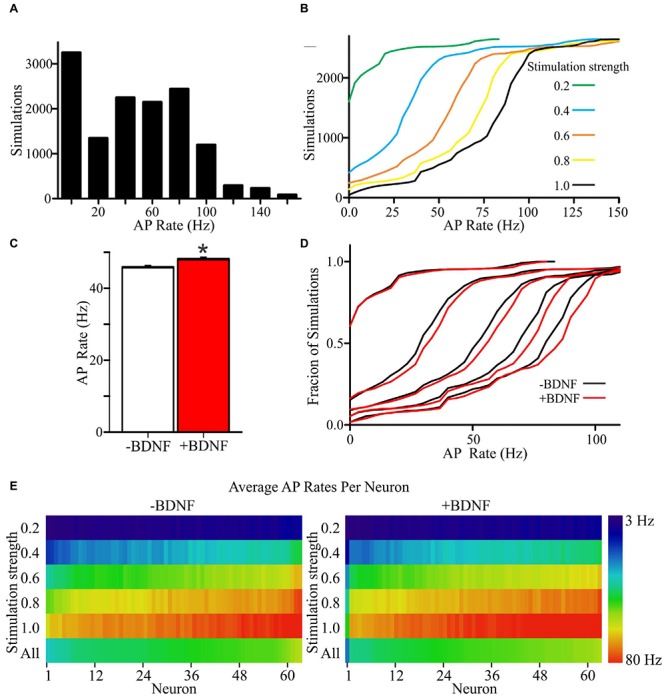
+Brain-derived neurotrophic factor model neurons exhibit an overall increase in APs relative to -BDNF model neurons. (A) A histogram shows the distribution of AP rates for all simulations. (B) Cumulative frequency plots for all simulations at each stimulation strength, with a stimulation strength of 1.0 representing the activation of all synaptic inputs. (C) The group average for the +BDNF simulations (red bar) is significantly elevated relative to -BDNF simulations (white bar). Error bars represent SEM; N = 6615 simulations per group; unpaired Students t-test; ∗p < 0.05. (D) Relative cumulative frequency plots demonstrate the increased firing in the +BDNF models (red lines) relative to the -BDNF models (black lines) at most stimulation strengths (0.2 to 1.0, increasing from left to right as in B). (E) Heat maps showing the average AP rate for every model neuron at all stimulation strengths (n = 63 each, -BDNF and +BDNF). For the purposes of ordering the model neurons in the heat map, the neurons were ranked according to their average firing rate across all simulations (“All”; bottom row). The rate of AP generation is color coded according to the scale at the right.